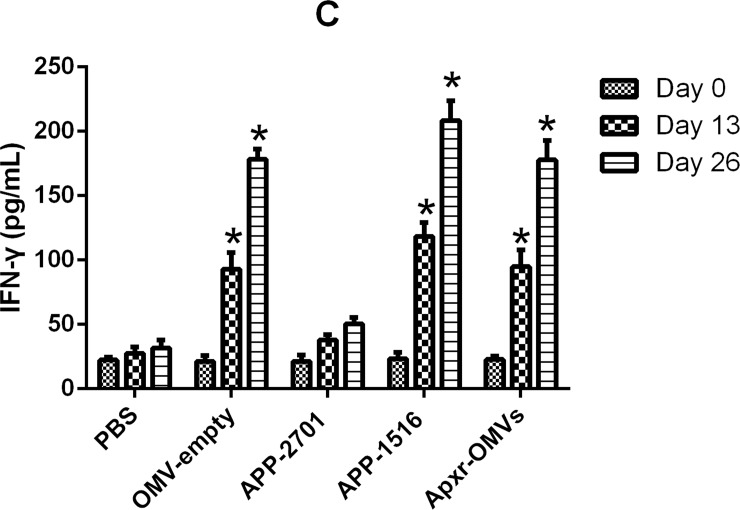
Cytokines detection assay.The levels of IFN-γ against OMV-empty, APP-2701, APP-1516 and Apxr-OMVs in sera.